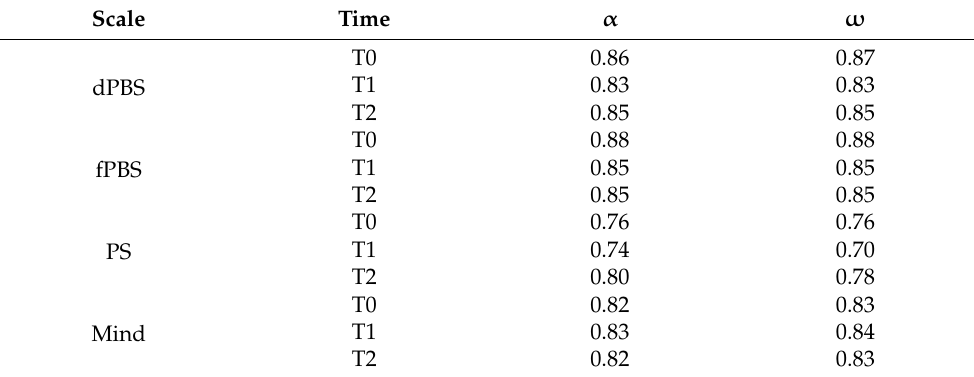
Table 1. Cronbach’s alpha ( α ) and McDonald’s omega ( ω ) values of psychobiosocial states, Italian perceived stress, and mindful attention awareness scales before intervention, after intervention and follow-up.